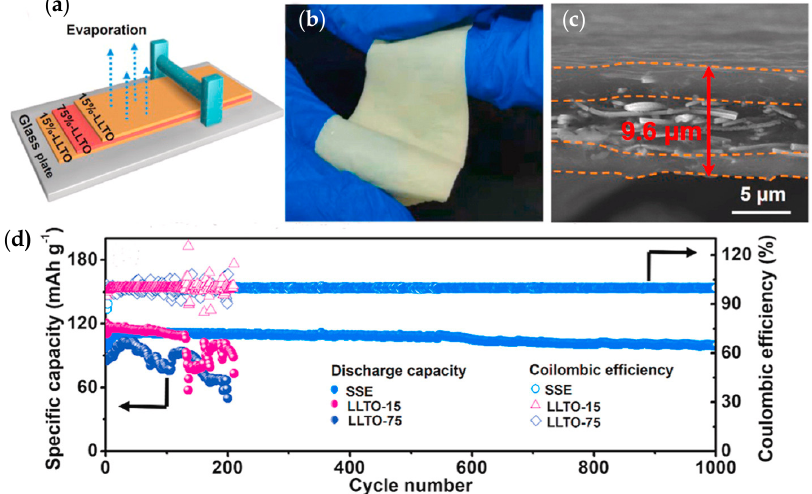
Figure 12. ( a ) The schematic illustration of the sandwiched SSE preparation by blade casting; ( b ) digital photograph of the bent sandwiched SSE; ( c ) the cross-sectional FE-SEM image of sandwiched SSE; and ( d ) battery performances of all-solid-state LMBs at 25 °C: Long-term cycling of assembled cell at 1C. Reprinted from [106], Copyright (2020), with permission from Elsevier. Jiang et al. [107] fabricated tape-cast ceramic LLTO film with a reduced thickness of